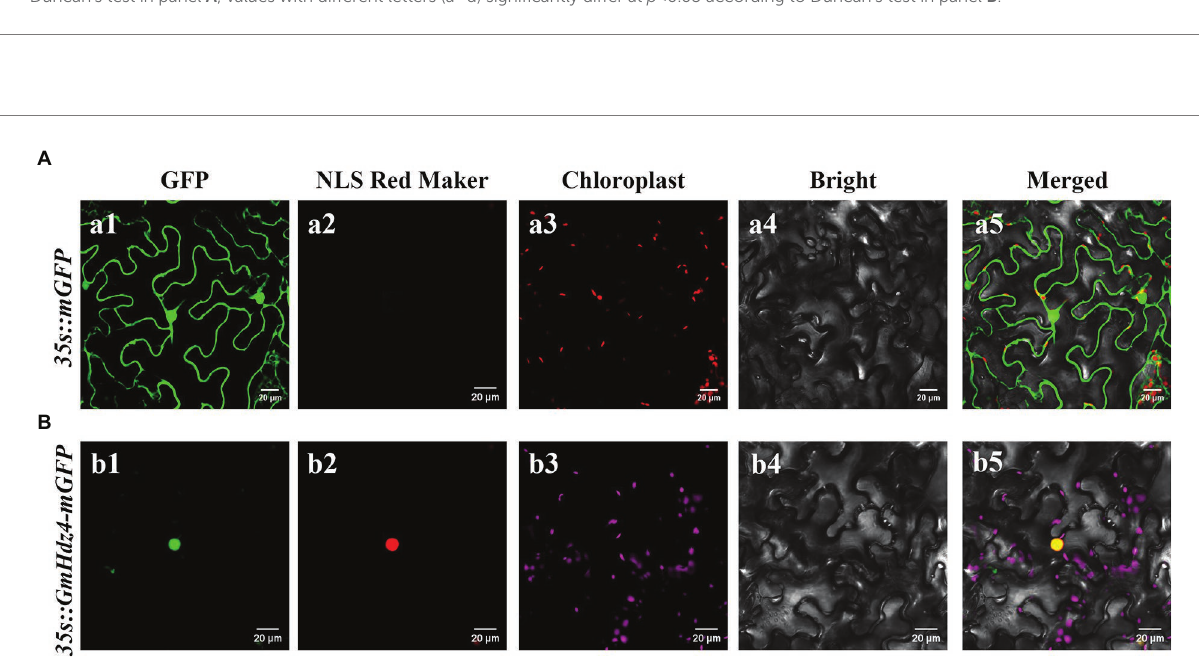
FIGURE 2 Tissue-specific and spatio-temporal expression of GmHdz4 . Expression pattern of GmHdz4 in various tissues in soybean (A) and PEG-induced expression pattern of GmHdz4 in root (B) . Significant differences are indicated by * and ** for p < 0.05 and p < 0.01, respectively, according to Duncan’s test in panel A ; values with different letters (a–d) significantly differ at p < 0.05 according to Duncan’s test in panel B .